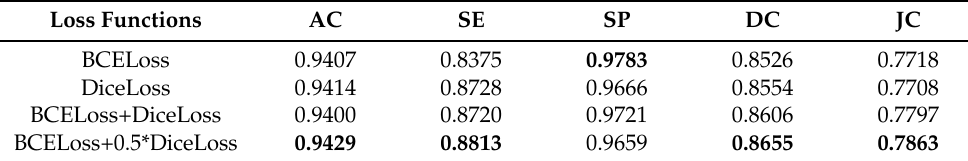
Table 9. Comparative experiments of loss functions results on the ISIC-2017 dataset.